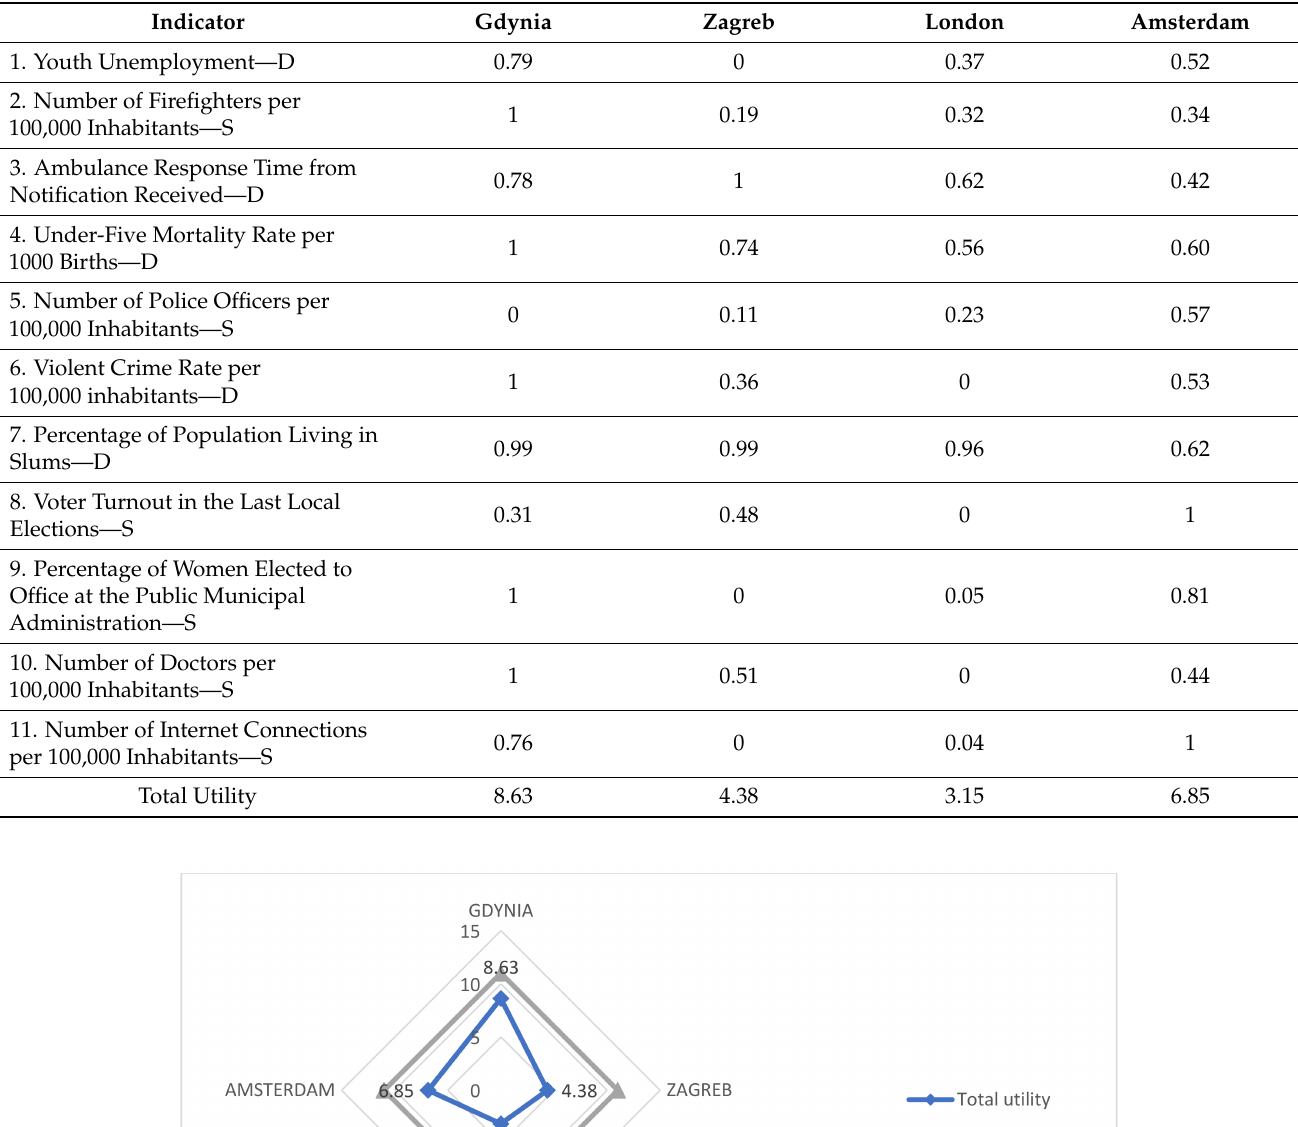
Table 2. Partial and total utility for the social dimension indicators in selected European cities. Indicator